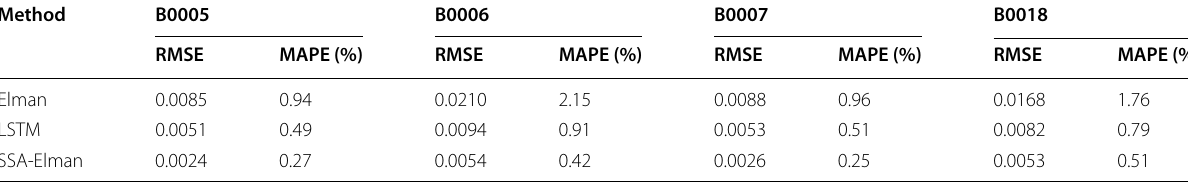
Table 7 The estimation error of 70% training data RMSE and MAPE